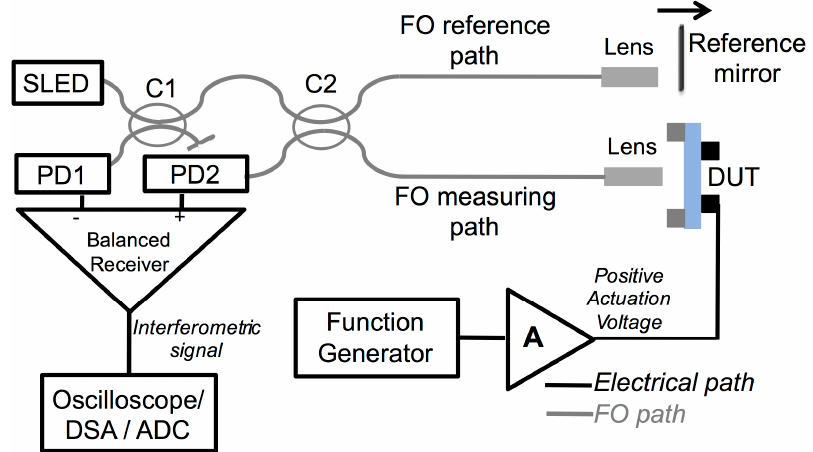
Figure 1. Instrumental and optical configuration of IR OLCR applied for characterizing piezo-actuated micro-membranes (MEMS Under Test). SLED: Superluminescent Light Emitting Diode; PD: Photodiode; C1, C2: 2 × 2, 50:50 fiberoptic coupler: FO: fiberoptic; DSA: Digital Signal Analyzer; ADC: Analog to digital conversion board; A: amplifier.